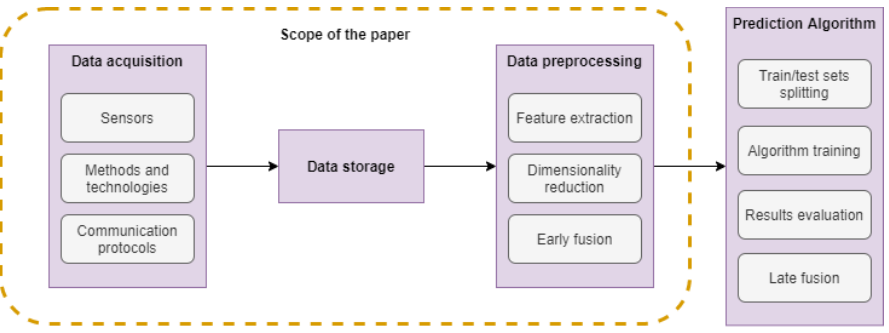
Figure 1. Flowchart that presents the typical analytic pipeline followed in manufacturing